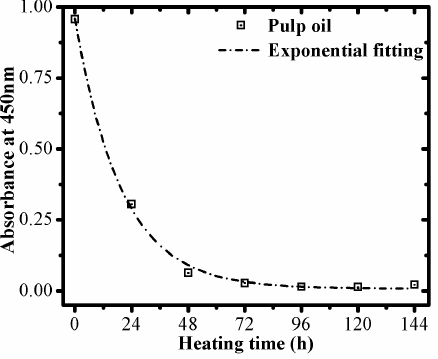
Figure 5. Pulp oil absorption at 450 nm as a function of the heating time.